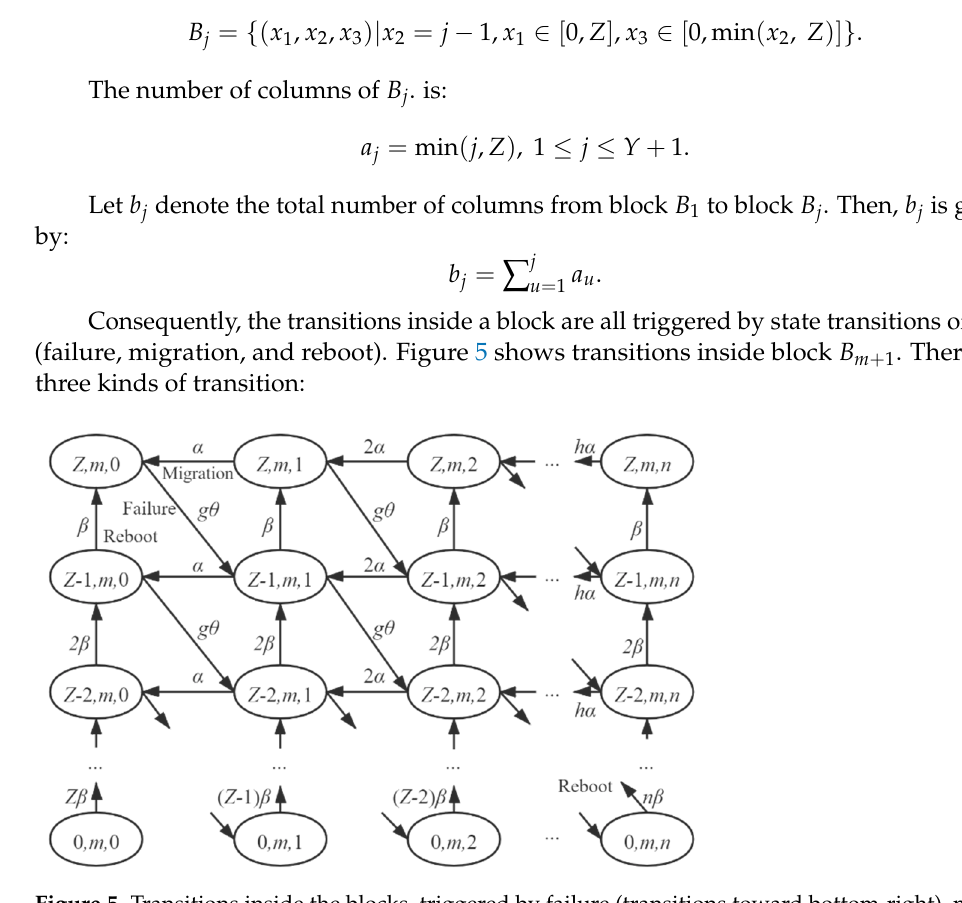
Figure 6. Transitions between blocks when 𝑥 (cid:2869) = 𝑍 − 𝑖 + 1 , triggered by the arrival (rightward transitions) or departure (leftward transitions) of tasks.